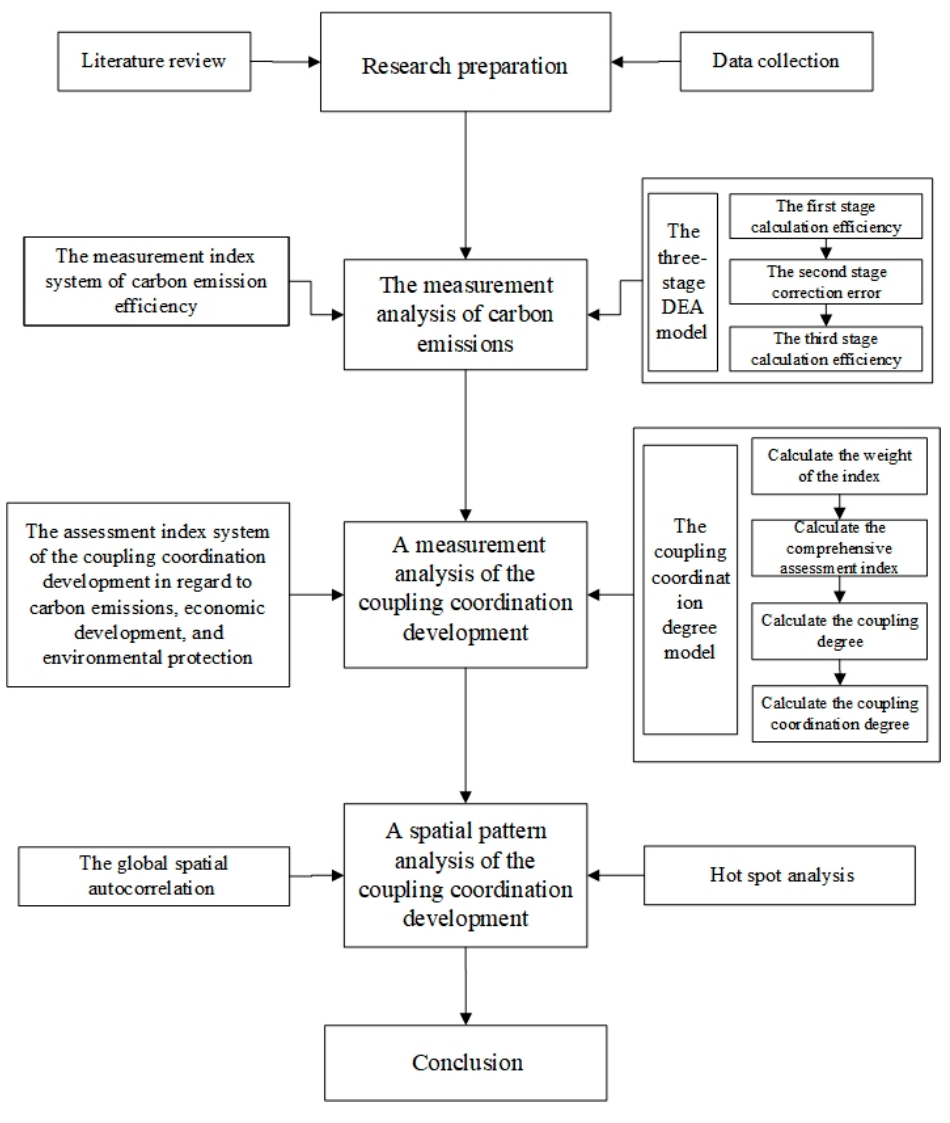
Figure 1. Technology Roadmap.